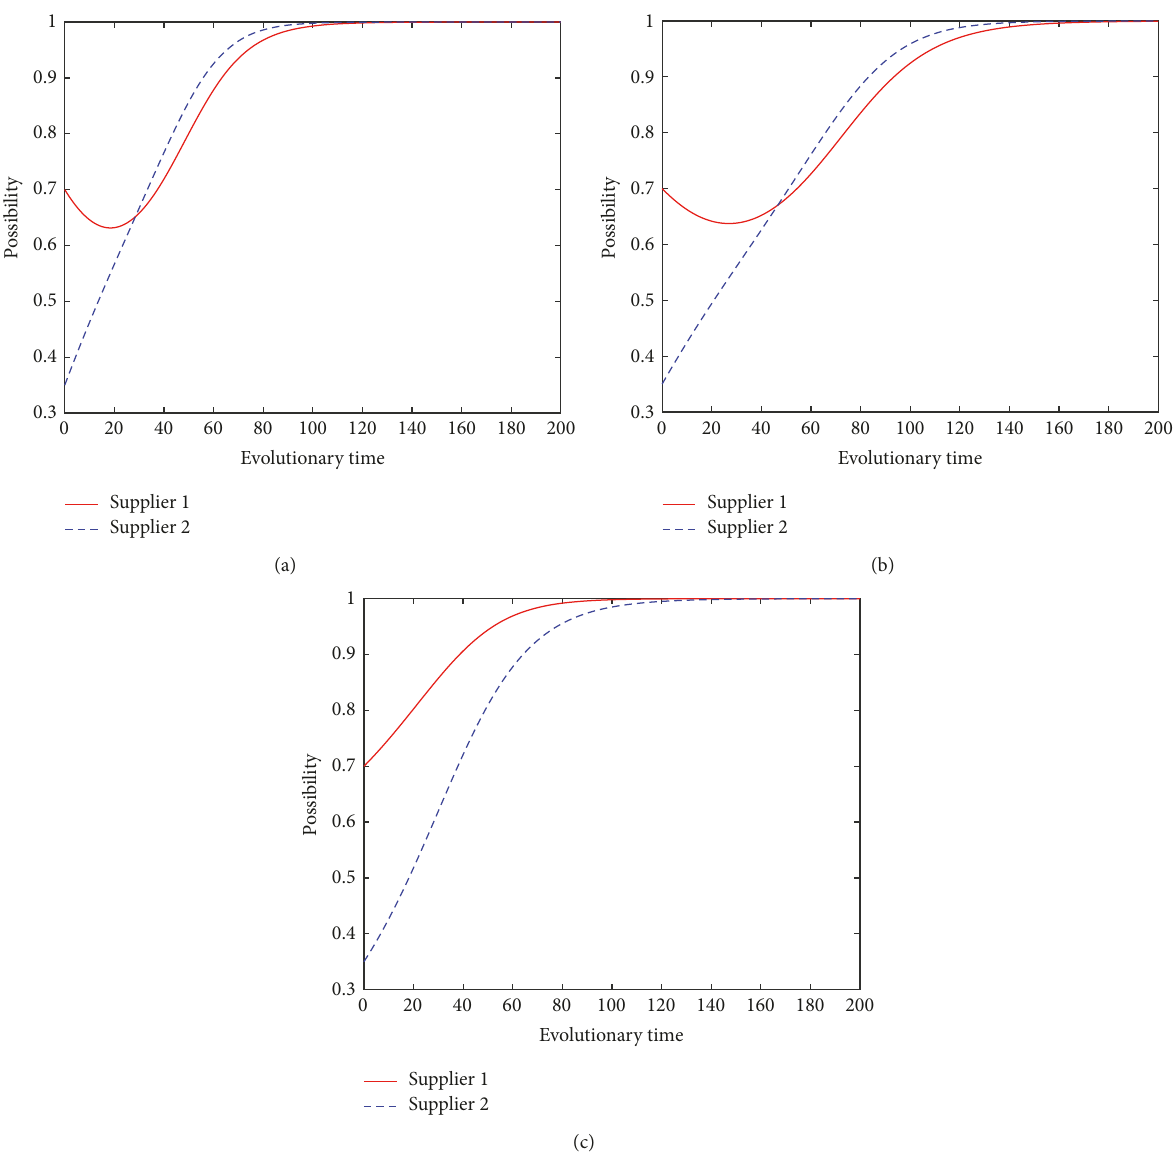
Figure 2: The evolutionary processes of products 1, 3, and